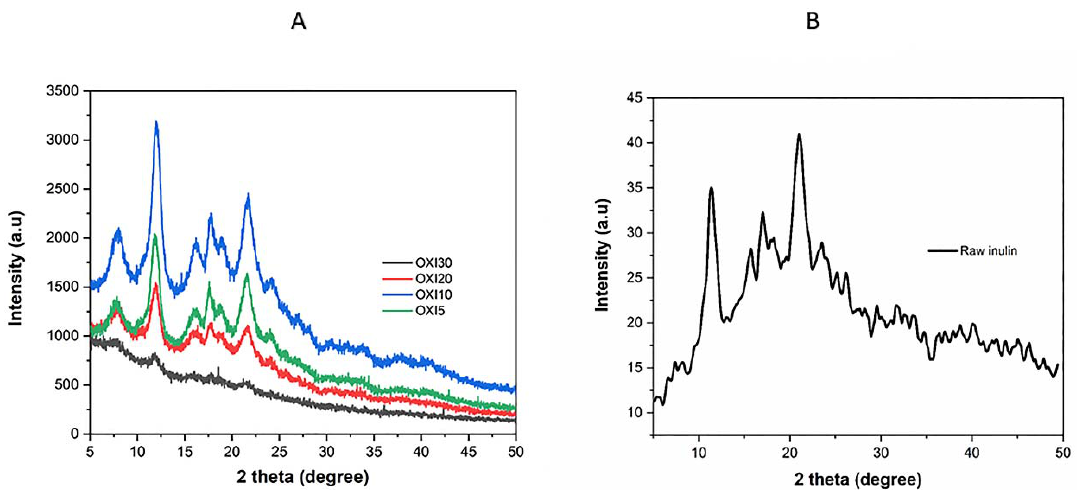
Figure 8. ( A ) XRD spectra of Oxi5, Oxi10, Oxi20, and Oxi30 samples and ( B ) raw inulin.